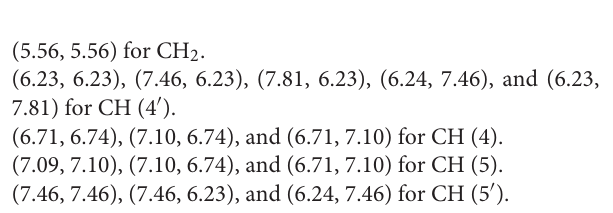
FIGURE 6 | Synthesis route and chemical structures of the mono-alkylated pyrazole and triazole